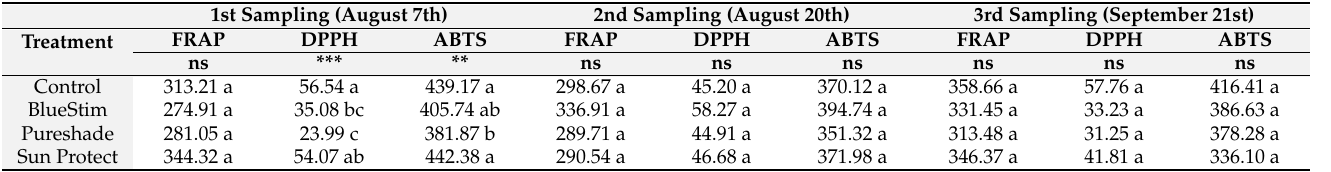
Table 5. Effects of alleviating products on kiwifruit leaf antioxidant capacity (FRAP, DPPH, and ABTS are expressed as µ moL equiv. Trolox g − 1